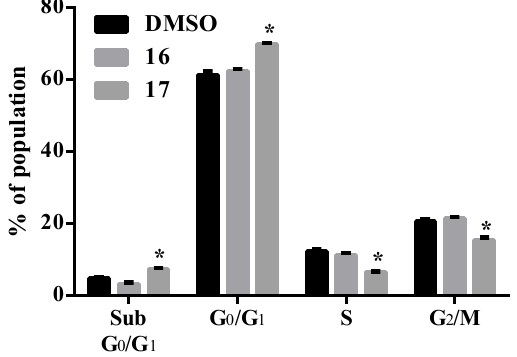
Figure 7. Comparative cell cycle distribution of SH-SY5Y cells after 72 h exposure to 10 µM of compounds 16 and 17. * p < 0.05.